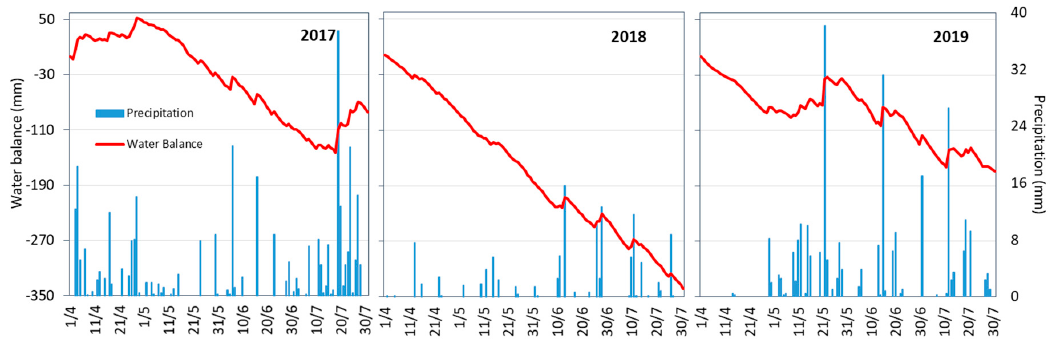
Figure 3. Precipitation and water balance (precipitation minus evapotranspiration) in the years 2017– 2019 in the Bohemian–Moravian Highlands region (2017 and 2019, Svépravice; 2018, Krasíkovice).